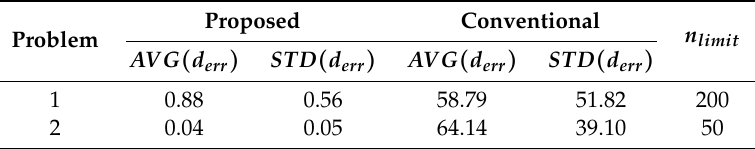
Table 3. The AVGs and STDs of the error distance ( d err ) for the methods with the limited number of iterations ( n limit